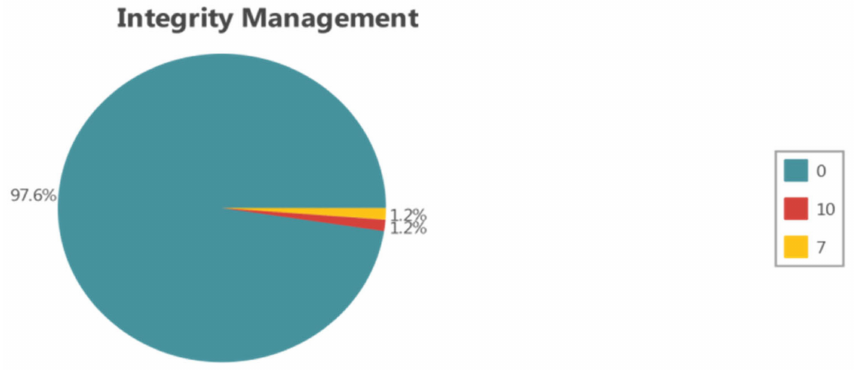
Figure 10. Effectiveness and efficiency of the